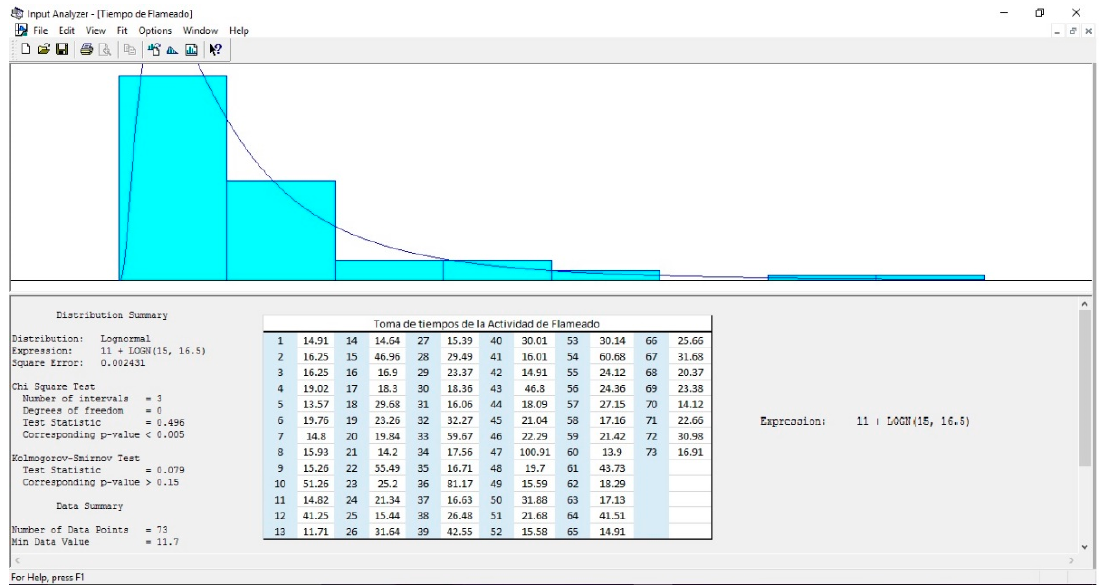
Figure 8. Probability distribution found for the flaming activity, elaboration in the Arena™ software.